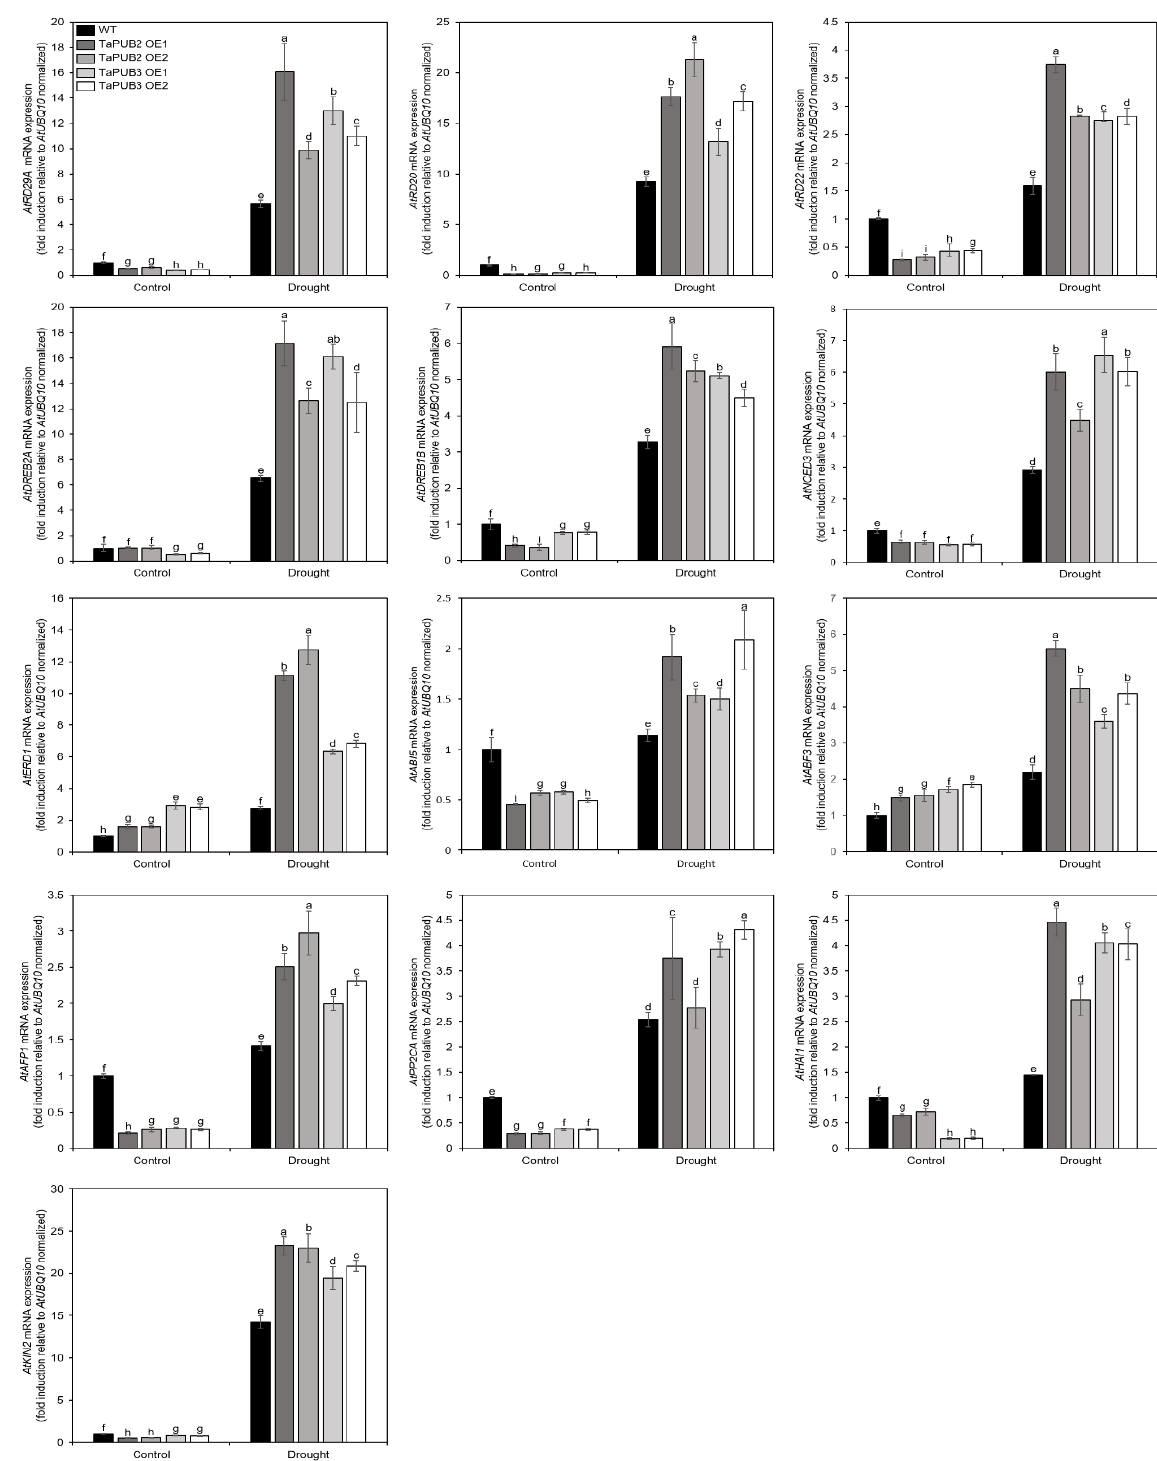
Figure 7. Real-time qRT-PCR analysis of drought-stress related maker genes. For dehydration treatment, the lid of the dish was opened under light for 5 h at room temperature. The induction patterns of various ABA- and/or drought-responsive genes ( RD29A, RD20, RD22, DREB2A, DREB1B, NCED3, ERD1, ABI5, ABF3, AFP1, PP2CA, HAI1 , and KIN2 ) were analyzed using qRT-PCR. Data represent the fold induction of each gene under dehydration (5 h) relative to the gene level of the control treatment (0 h). The mean values from three independent technical replicates were normalized to the levels of the internal control, UBC10 mRNA. Different letters indicate significant difference at ( p < 0.05) between the WT and 35S:TaPUB2 and 35S:TaPUB3 Arabidopsis transgenic